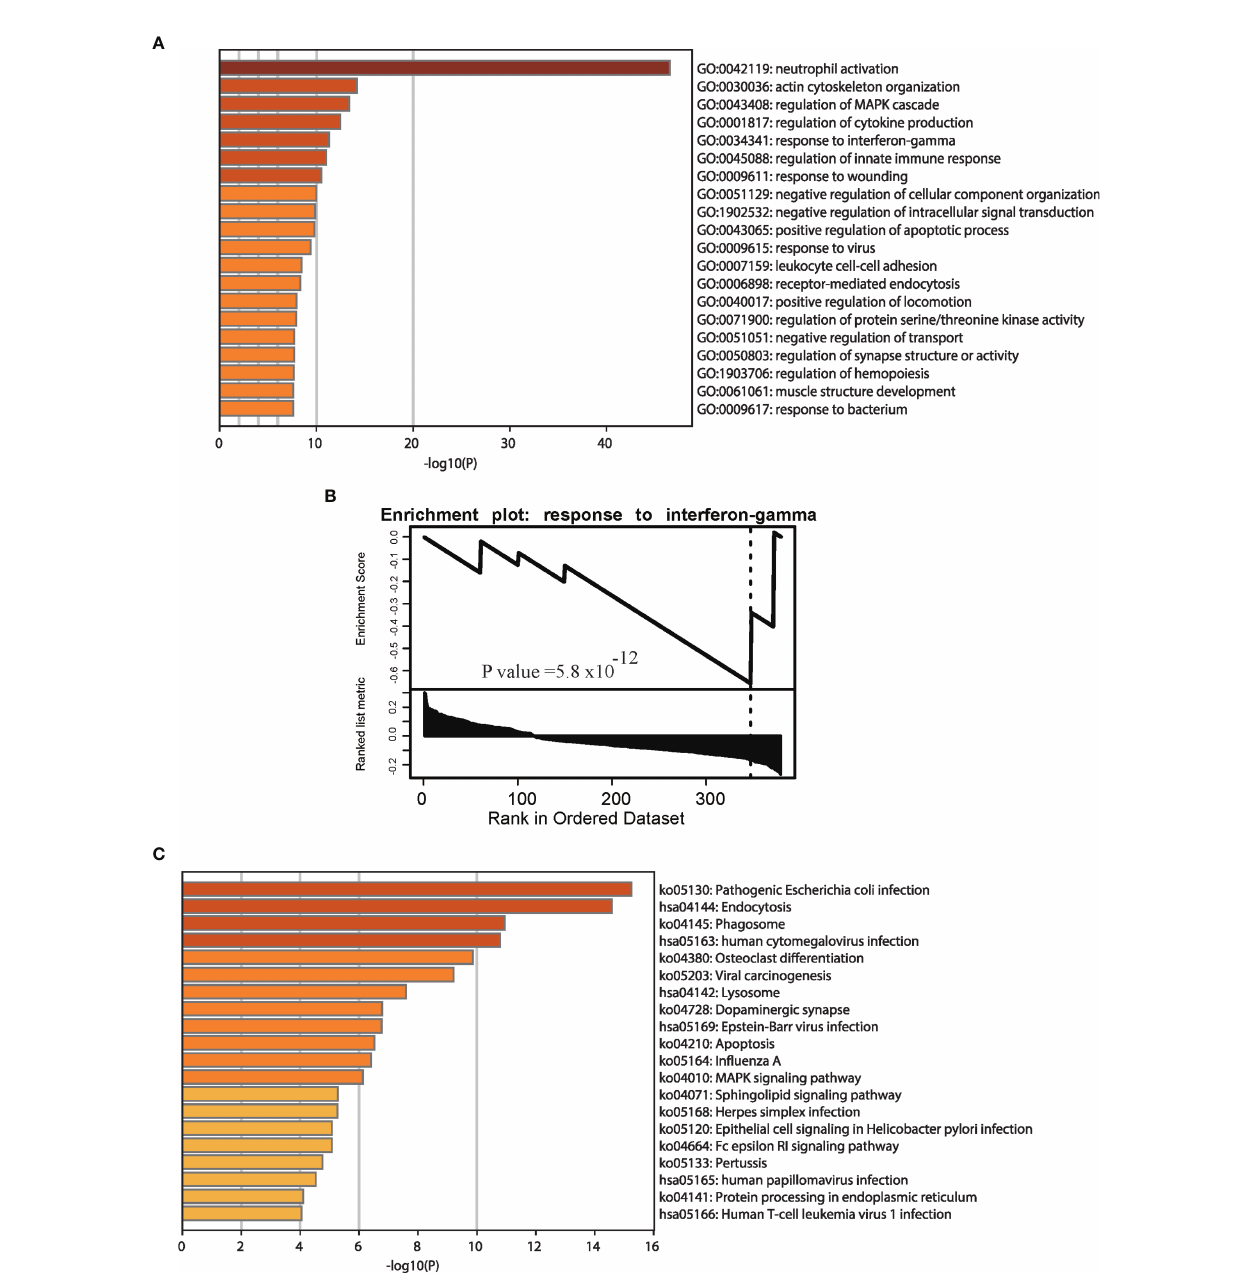
FIGURE 3 | Enrichment analyses of genes with signi fi cant APA changes. GO (A) and GSEA (B) enrichment analyses of genes with signi fi cant APA changes. (C) KEGG pathway enrichment analyses of genes with signi fi cant APA changes. The GO and pathway terms are displayed on the x-axis and are signi fi cantly enriched at − log10 (p